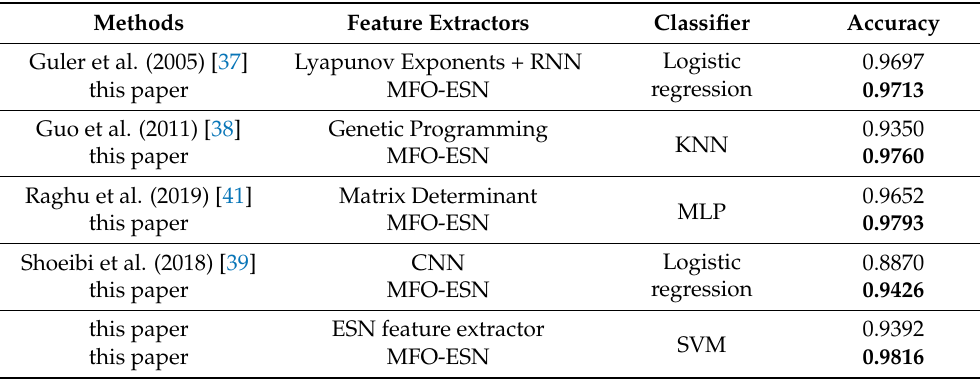
Table 2. The results of different classifiers using